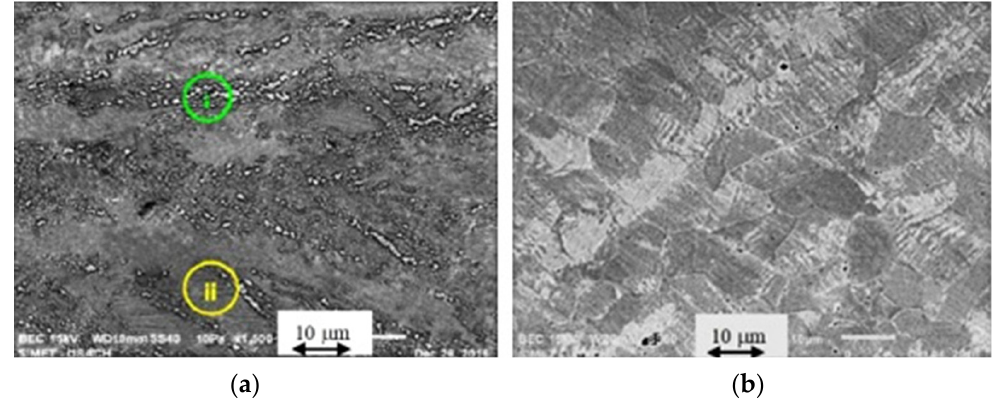
Figure 6. BEC images: ( a ) cold-deformed 80% and annealed at 500 °C for 72 h. ( b ) cold-deformed 80% and annealed at 675 °C for 24 h.